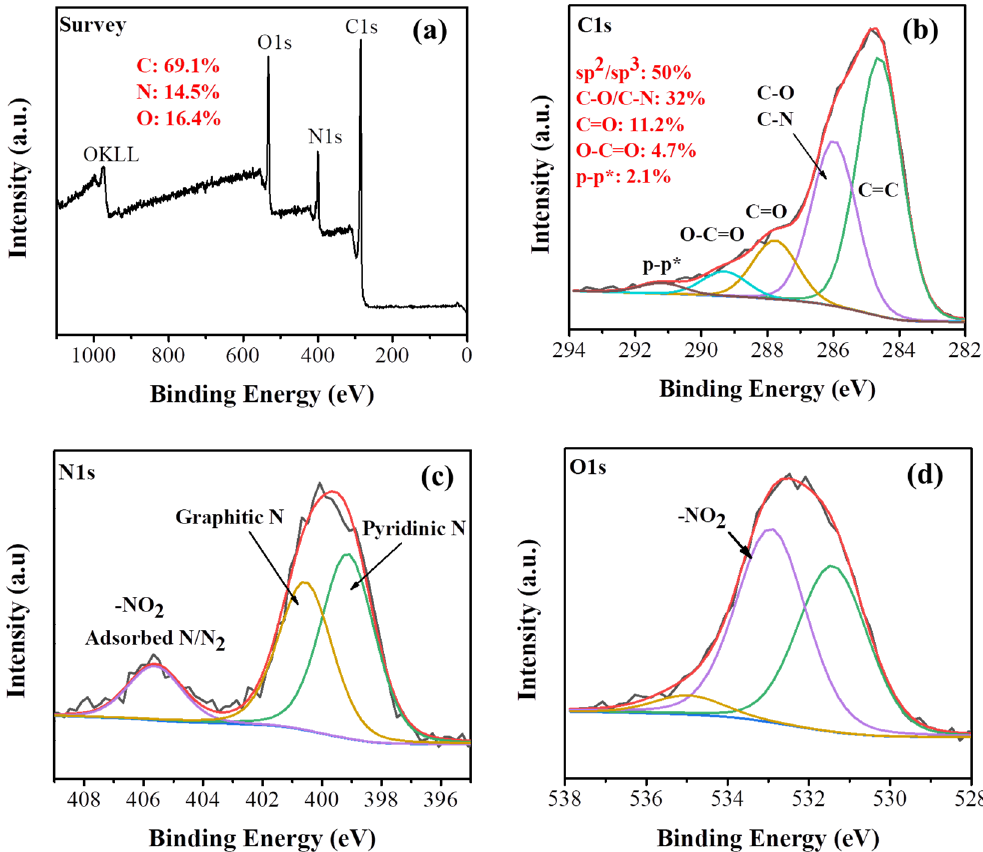
Figure 3. ( a ) X-ray photoelectron spectroscopy (XPS) survey spectrum, ( b ) C1s, ( c ) N1s and ( d ) O1s deconvoluted high resolution spectra of the carbon solid.